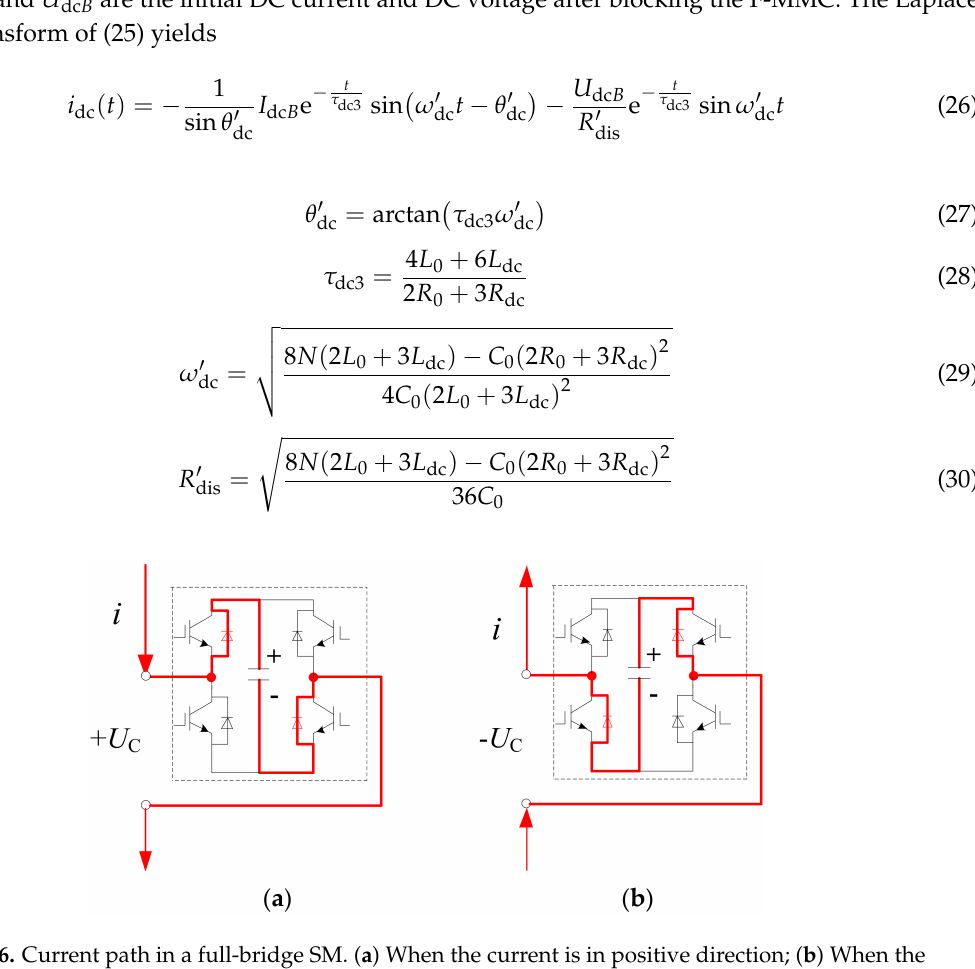
Figure 6. Current path in a full-bridge SM. ( a ) When the current is in positive direction; ( b ) When the current is in negative